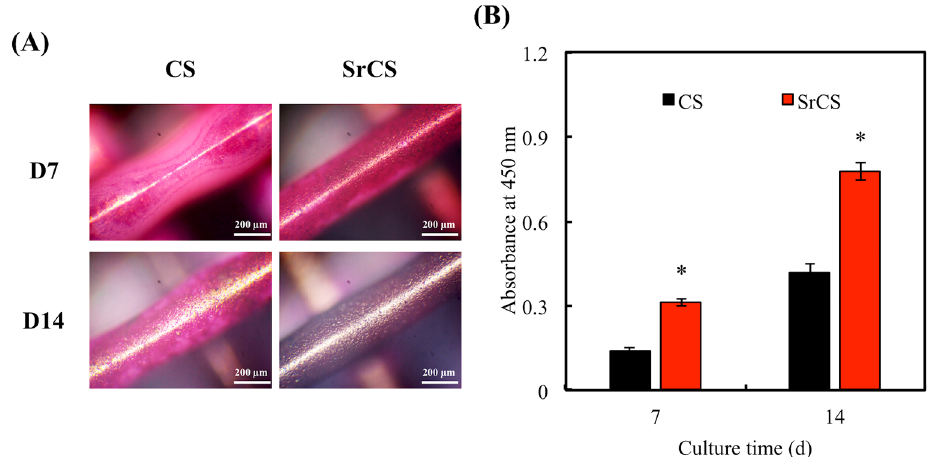
Figure 12. ( A ) Alizarin Red S staining and ( B ) quantification of calcium mineral deposits by MSCs. “*” indicates a significant difference ( p < 0.05) when compared to CS scaffold. Data presented as mean ± SEM, n = 3 for each group.